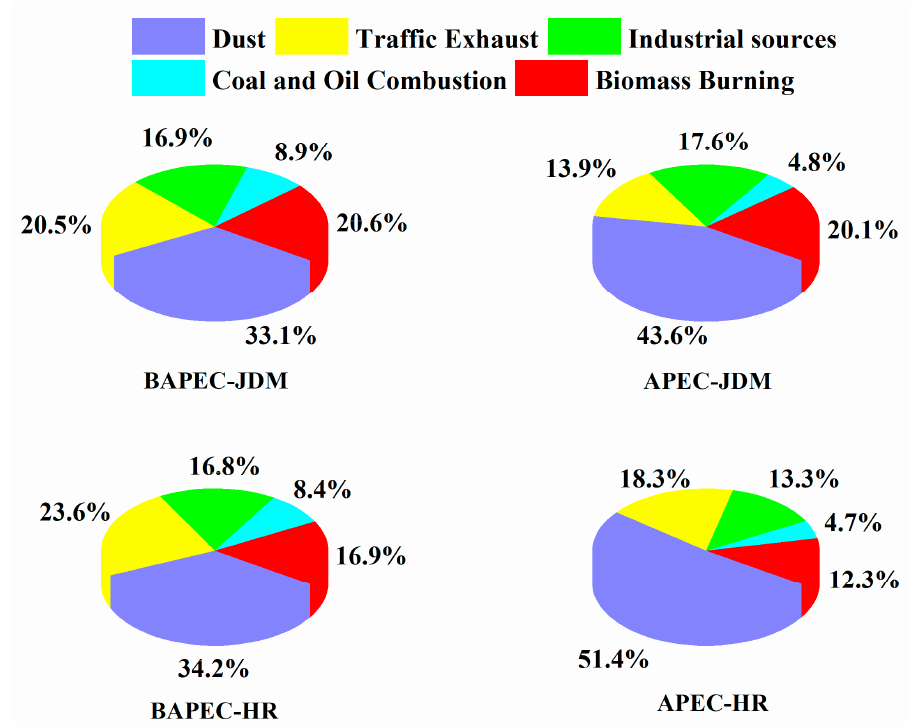
Figure 8. Source contribution of the five factor to metallic elements in PM 2.5 before and during the APEC summit in Beijing urban site (JDM) and suburban site (HR).